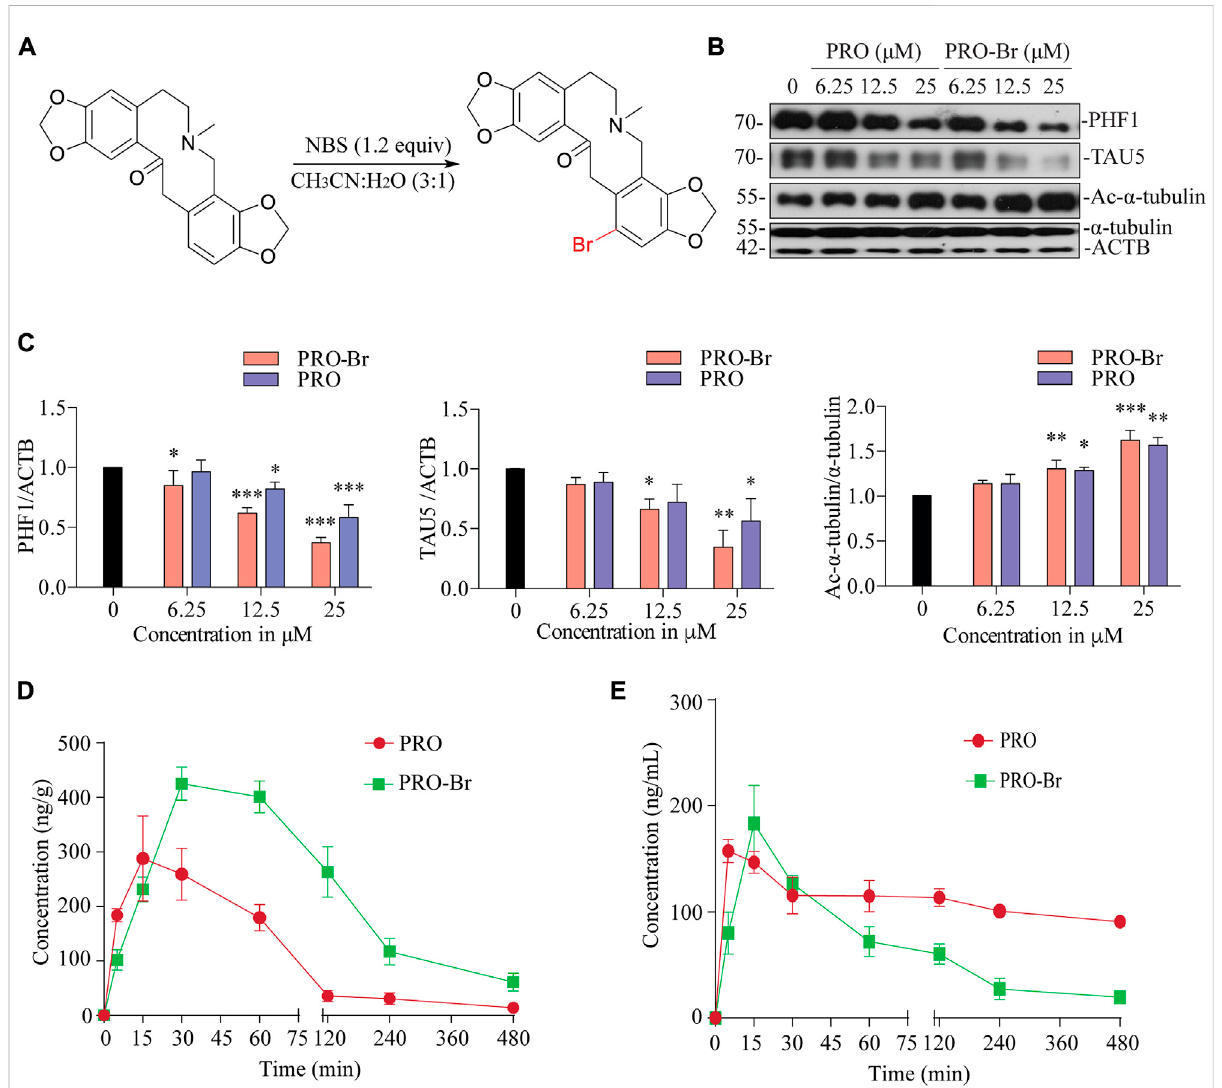
FIGURE 1 PRO-Br inhibits HDAC6 and promotes tau degradation (A) Scheme showing synthesis of PRO-Br from PRO. In SHSYP301L cells, (B) PRO-Br exhibited a 2-fold increase in potency compared to PRO for reducing HDAC6 deacetylase activity and tau accumulation (C) Data are presented as mean ± SEM of three replicates in a representative experiment for PHF1, TAU5 and Ac- α -tubulin. Pharmacokinetic pro fi les of PRO-Br (10 mg/kg) in (D) brain and (E)